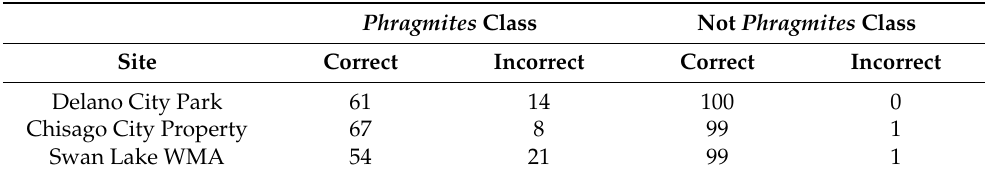
Table 16. Validation assessment points for each of the three validation sites for the random forest classification with the post-ML OBIA rule set.